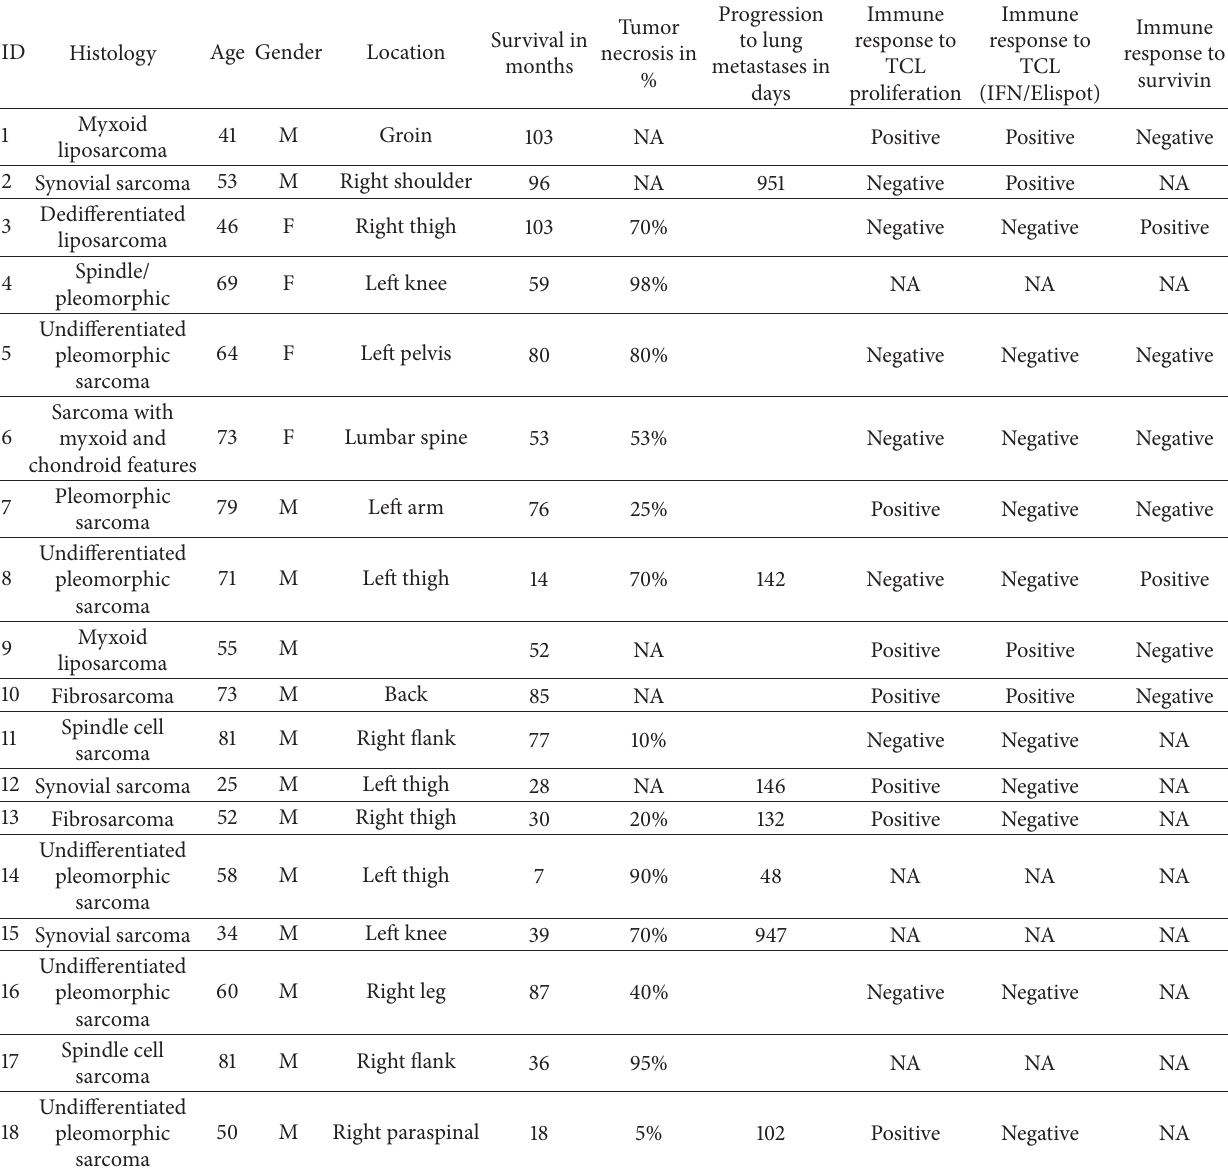
Table 3: Histological type, immune responses to tumor cell lysates, and proliferation and immune response to survivin, percentage of tumor necrosis, and survival in months data of 18 patients recieving neoadjuvant radiation and dendritic cell vaccine